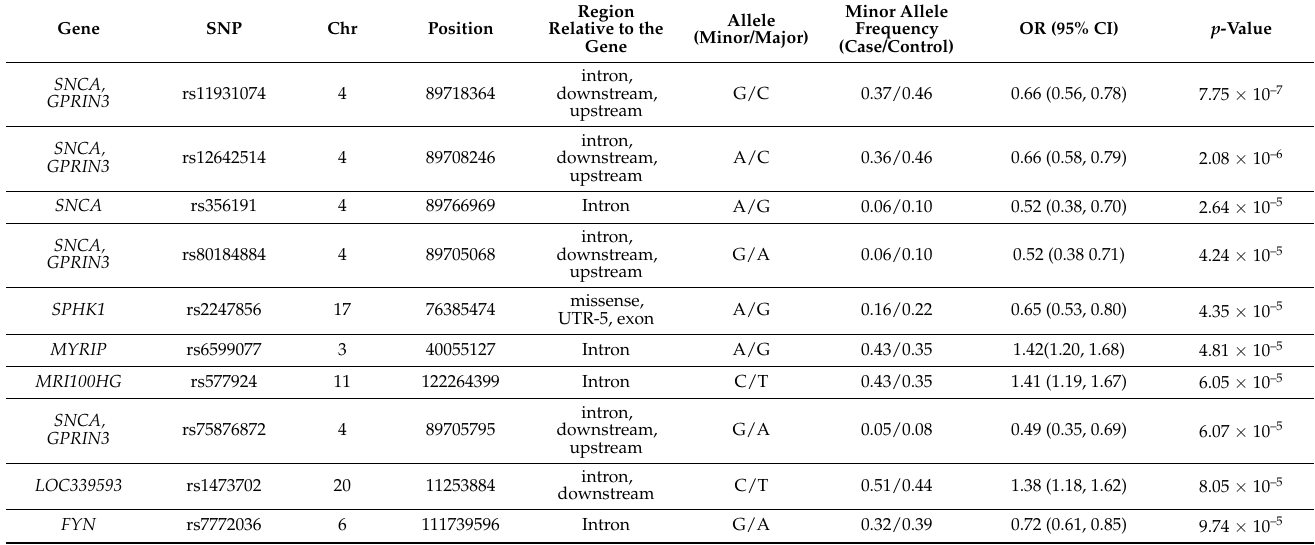
Figure 1. Manhattan plots for Parkinson’s disease (PD). The genes nearest to the top 10 significant variants are labeled. The x -axis represents the base pair position of the variants from chromosome 1 to chromosome 22. The SNCA loci showed a statistically significant association with PD after Bonferroni correction. SNCA SNP rs11931074 was most significantly associated with PD (OR = 0.66, 95% CI = 0.56–0.78, p = 7.75 × 10 –7 ). The SPHK1 and FYN loci were also associated with PD. Table 2. Top 10 genetic variants associated with Parkinson’s disease in the order of statistical